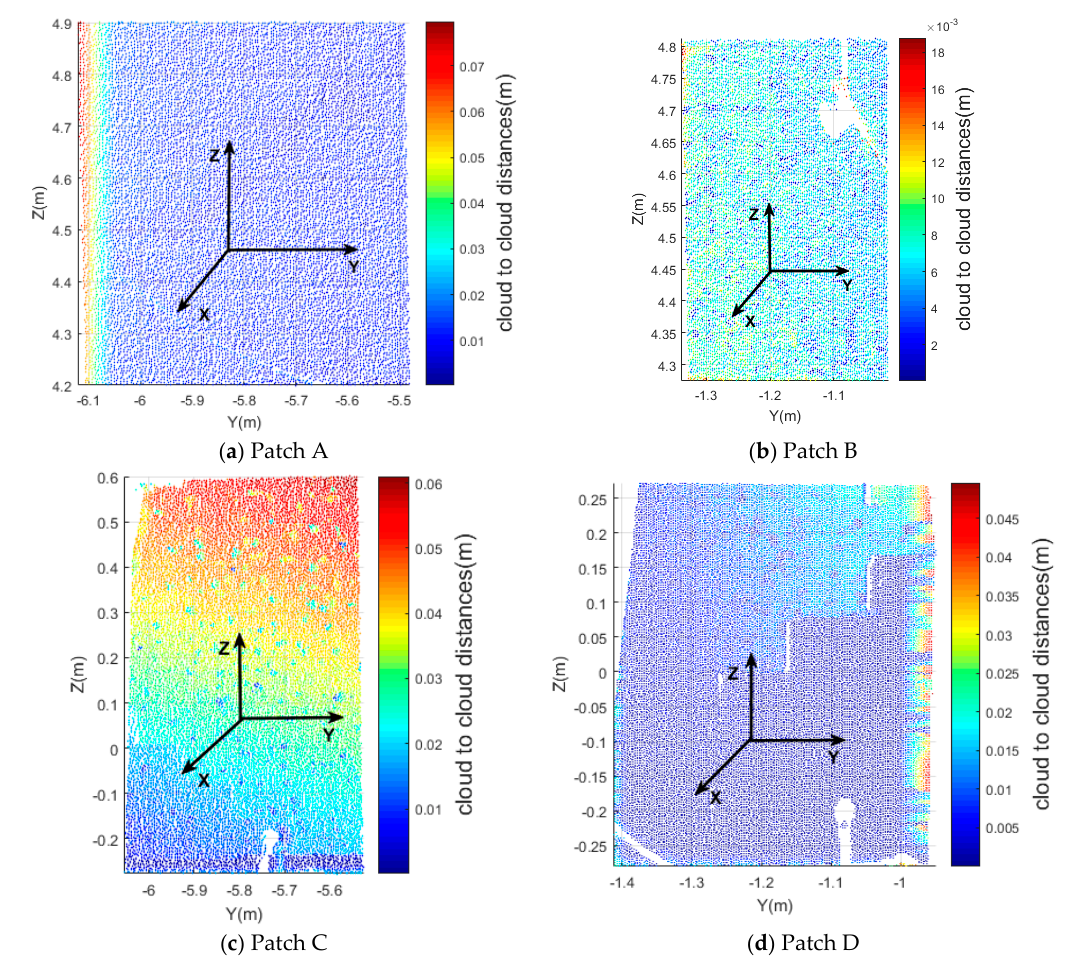
Figure 20. Scatter diagram of cloud-to-cloud distances.